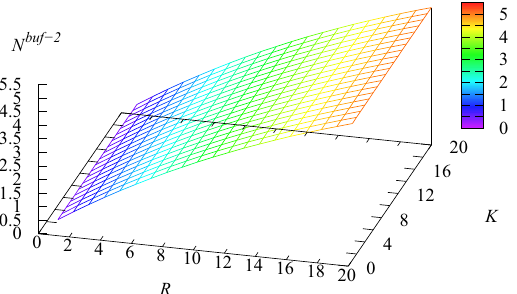
Figure 12. Dependence of the mean number of requests N buf − 2 in the second buffer on K and R .